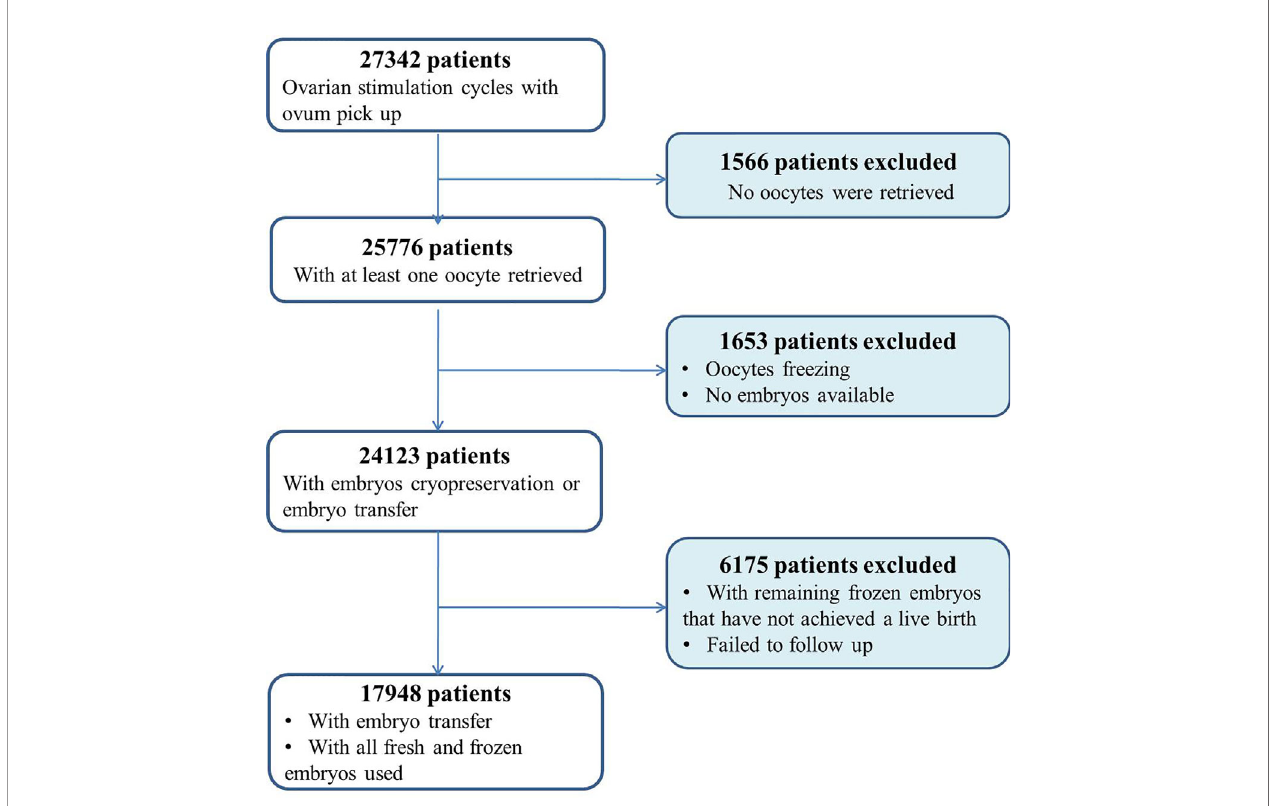
FIGURE 1 | Flow chart of patient selection and